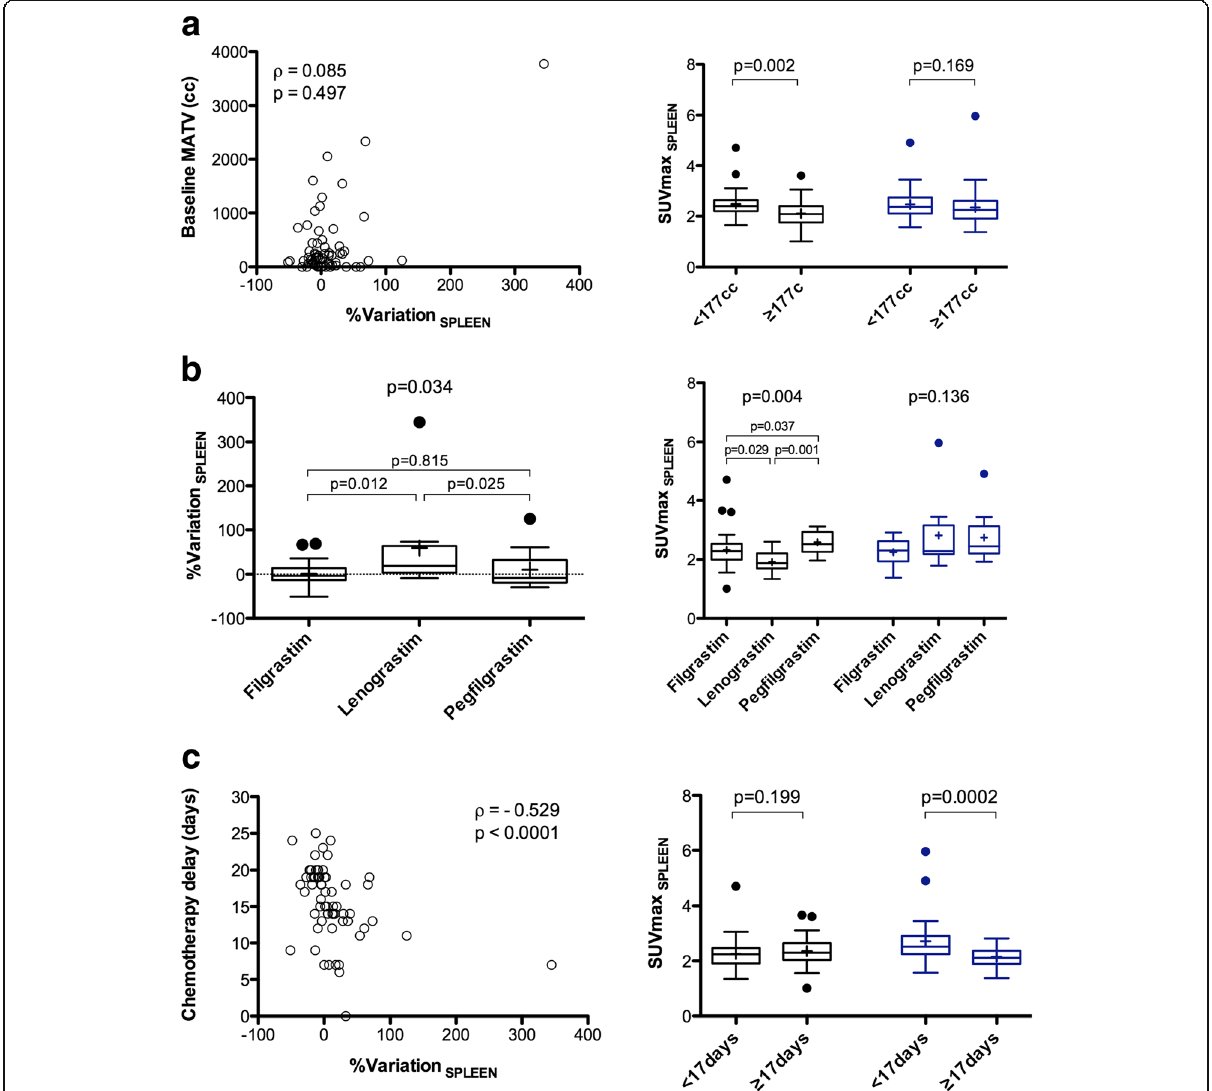
Fig. 5 Percentage variation (right panels) or absolute value (left panels) for spleen uptake between baseline and interim PET/CT, depending on the metabolic active tumour volume (MATV) on baseline scan ( a ), the type of G-CSF ( b ) and the time-lapse between the last injection of chemotherapy and the PET/CT examination ( c